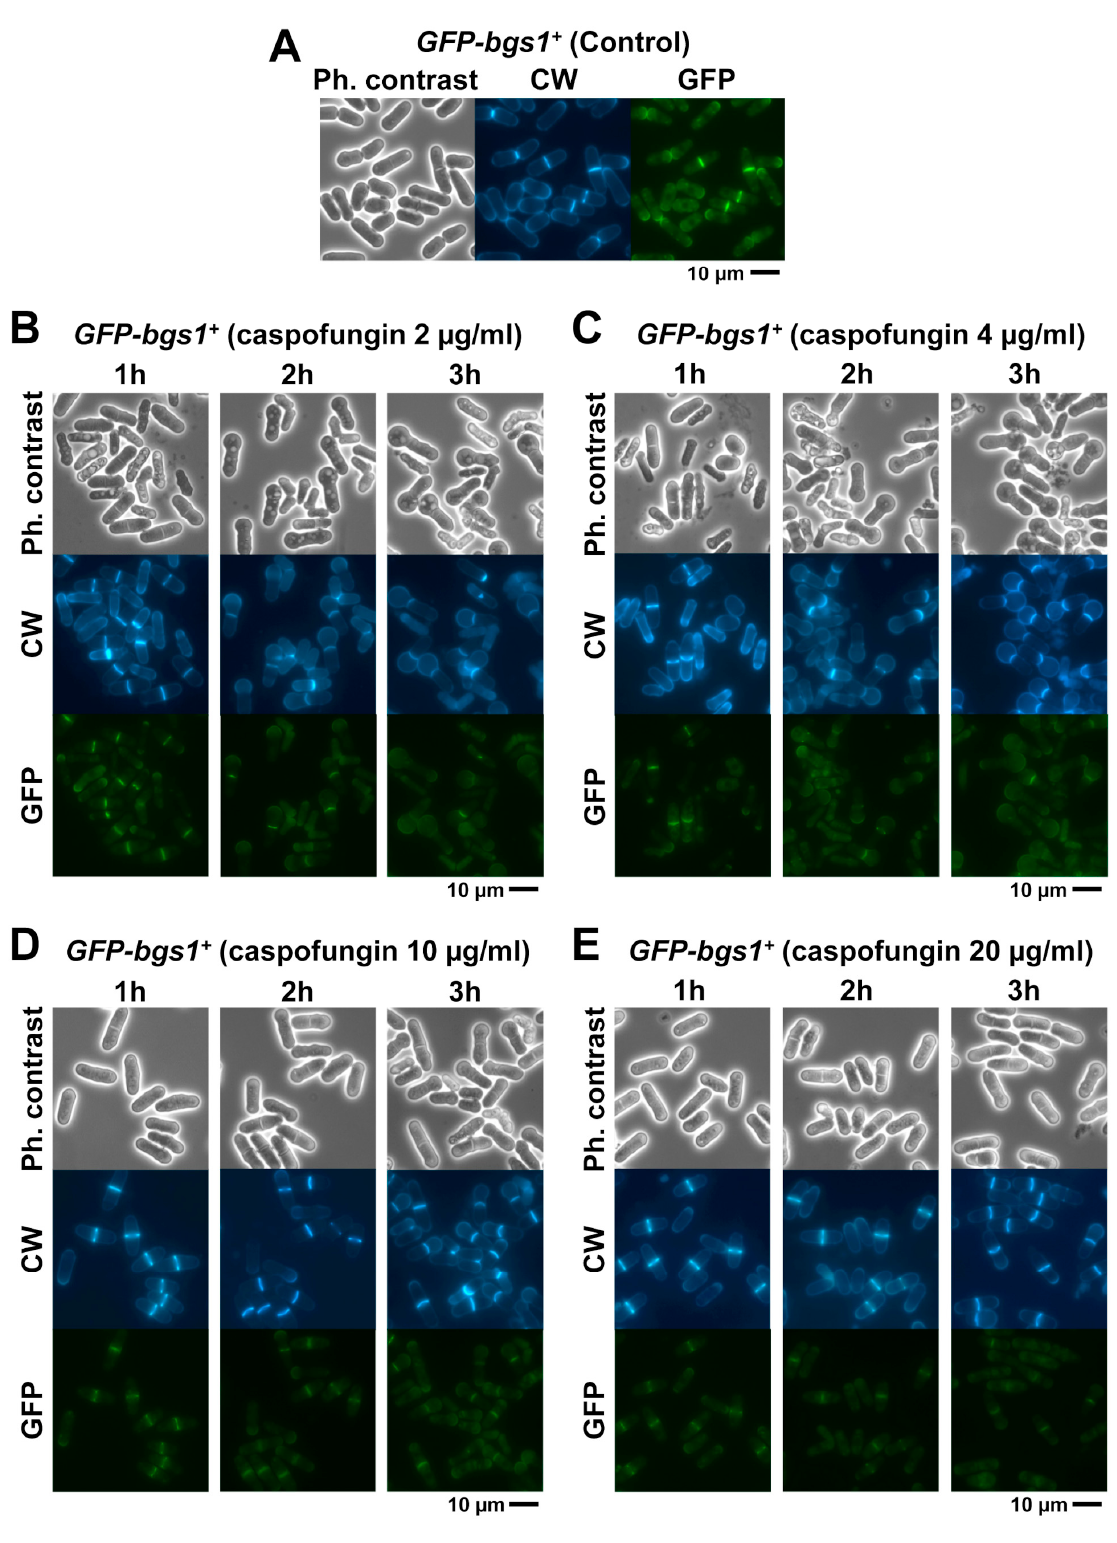
Figure 2. Cell morphology and GFP-Bgs1 localization in cells growing in the presence of sublethal and lethal concentrations of caspofungin. Phase-contrast and fluorescence micrographs of calcofluor white (CW)-stained GFP-bgs1 + cells. Cells were grown to early log phase at 28 ◦ C in YES liquid medium and imaged at the indicated times using phase-contrast and CW and GFP fluorescence microscopy either in the absence (( A ): control) or in the presence of sublethal (( B ): 2 µ g/mL; ( C ): 4 µ g/mL) or lethal (( D ): 10 µ g/mL; ( E ): 20 µ g/mL) doses of the antifungal. Scale bars: 10 µ